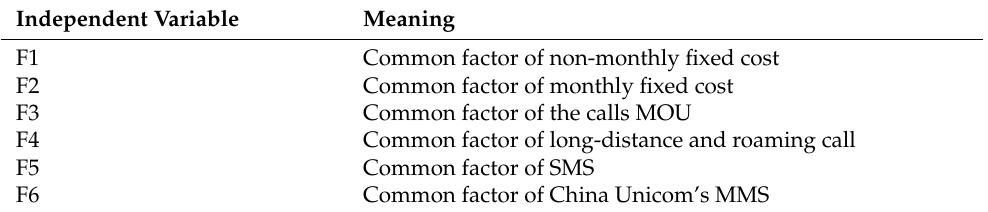
Table 3. The meanings of independent variables—adapted from Zhang [6].